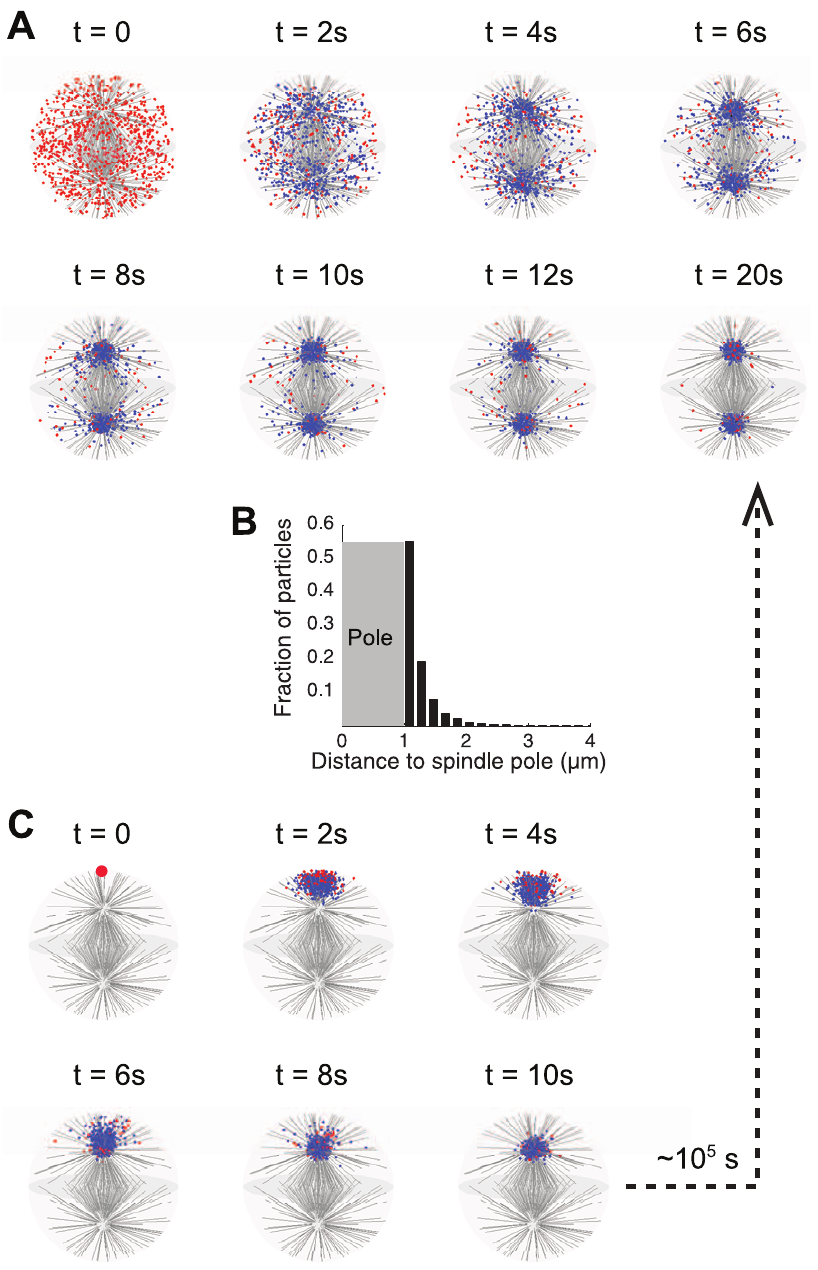
Figure 1. Simulated dynein sequestration by the microtubule spindle. (A) Time series of dynein distribution (also see Movie S1). Dyneins are initially randomly distributed throughout the cytoplasm. Dark grey lines: microtubules (only 1 out of 10 are shown to reduce clutter); blue dots: dyneins bound to microtubules; red dots: dyneins freely diffusing in the cytoplasm. Dyneins become strongly concentrated around the spindle poles within 20 s. (B) Histogram (right) of the equilibrium distribution of dyneins. More than 50% dyneins are concentrated within 200 nm around the spindle pole, and 98% within 1 m m. (C) Dyneins are initially released from one end of the cell, close to one spindle pole (big red dot) (also see Movie S2). Legends are same as in (A). Dyneins become strongly concentrated around the proximal spindle pole within 10 s, but almost none on the opposite spindle pole. Over the simulated duration of 3000 s, only 0.3% dyneins turn over to the opposite pole. Assume that the turnover is a Poisson process, then prob (wait time , t)=1 2 exp( 2 t / t ), where t is the characteristic turnover time, or the reciprocal of the turnover rate. Plugging in prob =0.003 and t =3000 s gives t =10 5 s. Both simulations in (A) and (C) are carried out with 1000 non-interacting dyneins and each half-spindle consisting of 800 spindle microtubules and 800 astral microtubules. The dyneins are expelled from the spindle pole immediately as they arrive, i.e. the spindle poles are reflecting boundaries. doi:10.1371/journal.pone.0034919.g001 Intuitively, the microtubule density is critical for the spatial binding molecules. Figure 2 demonstrates that the increase of regulation effect; thus the change in the microtubule density over microtubule density enhances the sequestration effect (defined as the fraction of bound particles) and the concentration effect the cell cycle can affect the spatial pattern of the microtubule-